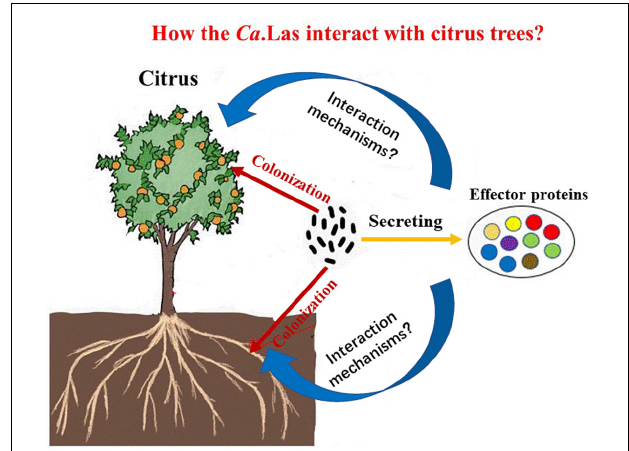
FIGURE 3 | The interaction process between citrus and Candidatus Liberibacter asiaticus ( Ca. Las). Ca. Las can more easily colonize in roots, stems, and leaves of citrus through effector proteins. To analyze the interaction mechanism of plant and pathogen is conducive to promote the development of HLB prevention and control. HLB,